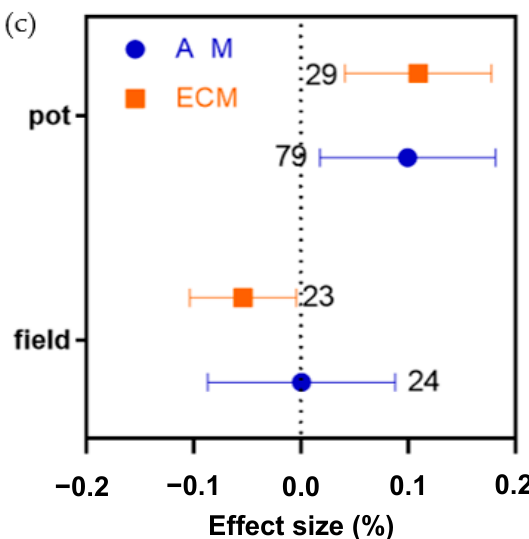
Figure 6. The average effect of drought on ectomycorrhizal plant N, ( a ) P, ( b ) and N:P ratio, ( c ) and arbuscular mycorrhizal plant N, ( a ) P, ( b ) and N:P ratio, ( c ) under field or pot experiment. The error bar represents a 95% bootstrap confidence interval (CI). If the 95% CI of effect size did not overlap with zero, drought stress was considered to be the effect. The number of observations for each category is shown next to the error bar.